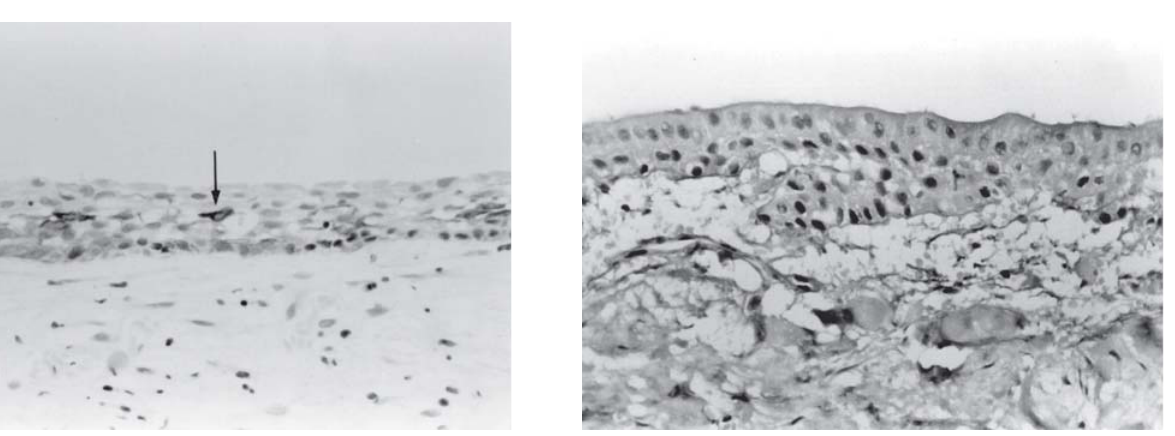
FIGURE 5- Reduced enamel epithelium: Detection of CK13 in disperse cells (arrow). X400